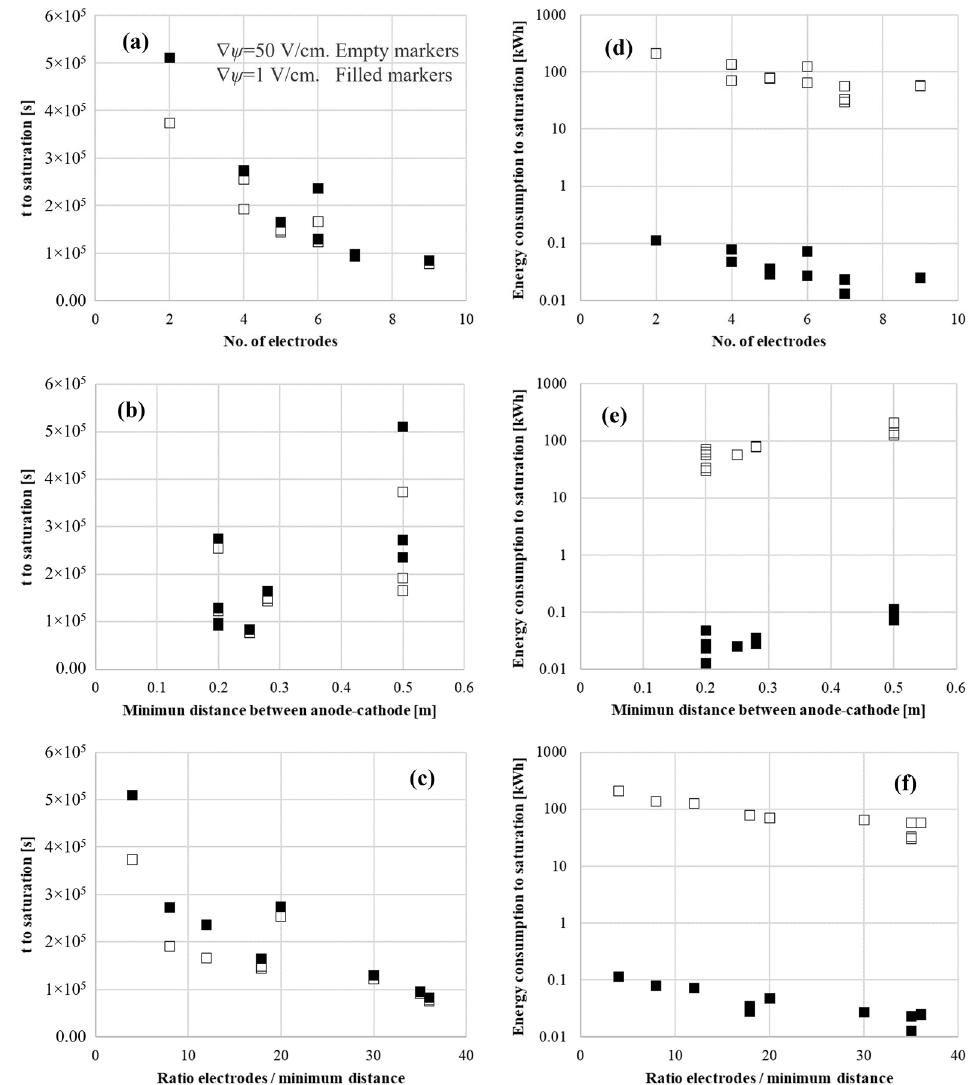
Figure 7. Time to saturation depending on the ( a ) number of total electrodes, ( b ) minimum distance between the anode–cathode, and ( c ) ratio of electrodes/minimum distance. Energy consumption to saturation depending on the ( d ) number of total electrodes, ( e ) minimum distance between the anode–cathode, and ( f ) ratio of electrodes/minimum distance. ∇ ψ = 50 Vcm − 1 is indicated by empty markers and ∇ ψ = 1 Vcm − 1 is indicated by filled